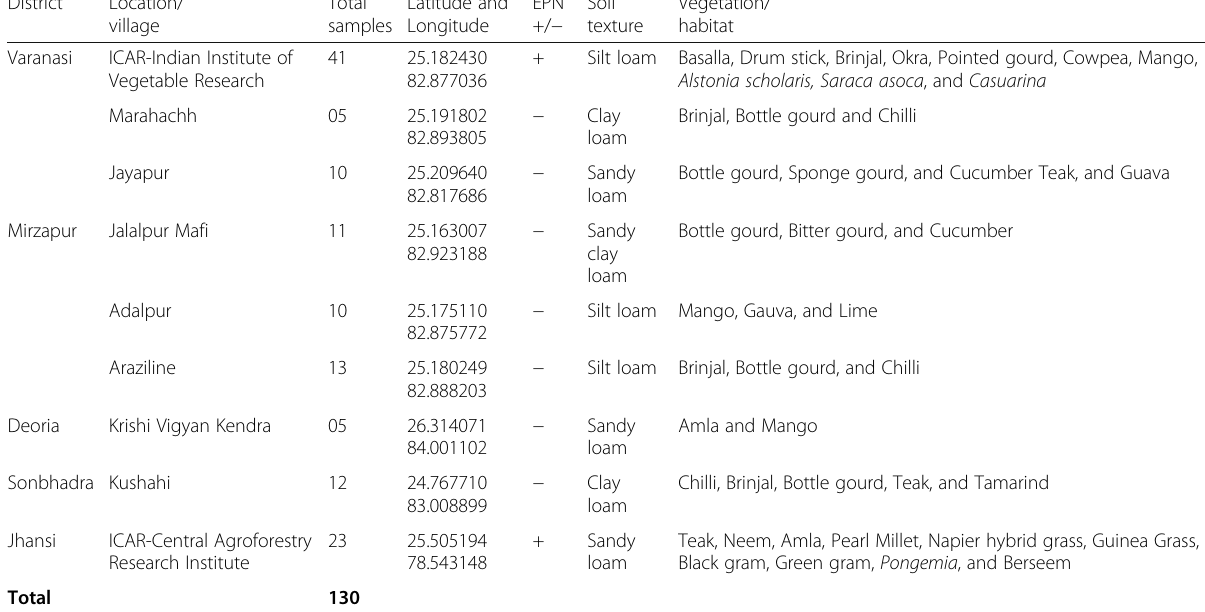
Table 1 Details of soil samples collected from different habitats from Purvanchal and Bundelkhand Region of Uttar Pradesh, India District Location/